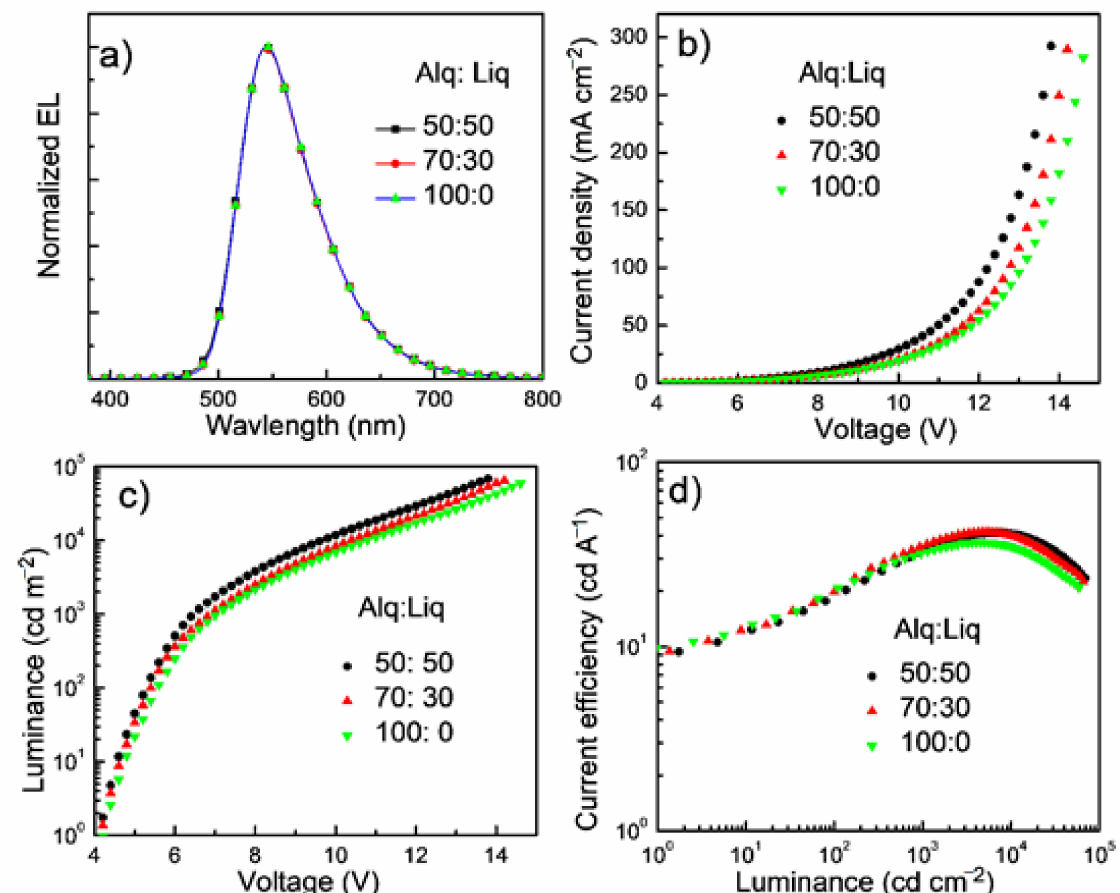
Figure 2. ( a ) Normalized electroluminescence (EL) spectra, ( b ) current density-voltage, ( c ) luminance-voltage and ( d ) current efficiency-luminance characteristics of tetra-Pt-S-based phosphorescent organic light-emitting diodes (PhOLEDs) with different weight ratio of Alq 3 :Liq in electron-transporting layer